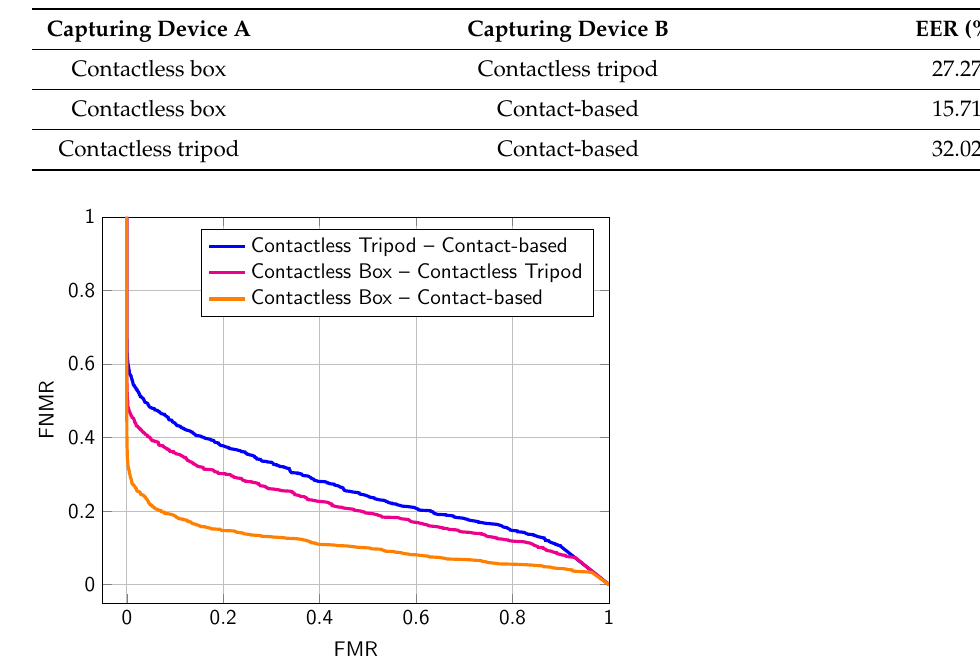
Figure 12. DET curves obtained from the interoperability of different subset of the collected data: Comparison of fingerprints captured with different setups. All captured fingers (finger-IDs 2–5 and 7–10) are